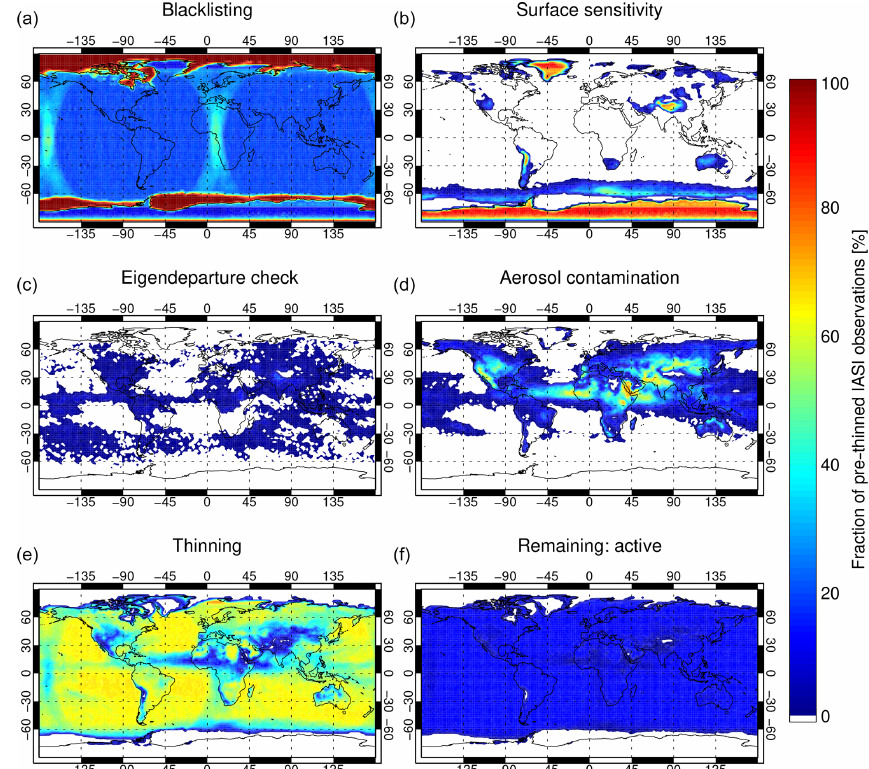
Figure 2. Percentage of IASI all-sky observations failing quality and thinning checks (a–e) and percentage used actively in data assimila- tion (f) , from 1 to 20 June 2017. The total in every latitude–longitude binning box adds up to